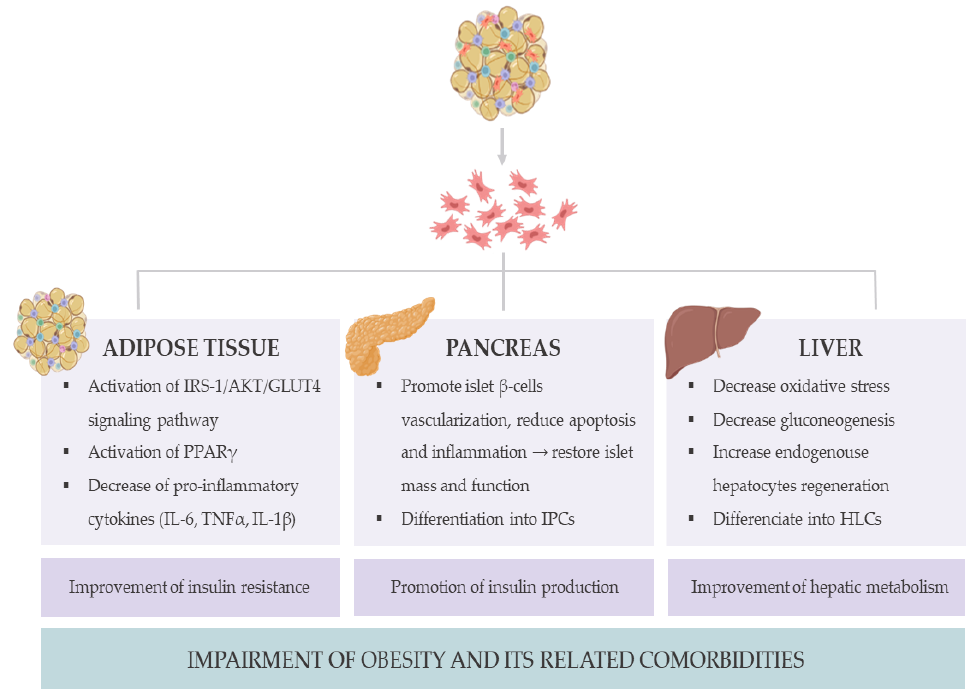
Figure 1. The mechanisms of action of ADMSC on obesity treatment. The transplantation of ADMSC reduces adipose tissue inflammation, restores glucose homeostasis by improving insulin sensitivity and promoting insulin production, and reverses liver steatosis. Abbreviation: ADMSCs, adipose- derived mesenchymal stem cells; AKT, serine/threonine kinase 1; GLUT4, glucose transporter 4; HLCs, hepatocyte-like cells; IL-1β, interleukin 1β; IL-6, interleukin 6; IPCs, insulin-producing cells; IRS-1, insulin receptor substrate 1; PPAR-γ, peroxisome proliferator-activated receptor gamma; and TNF-α, tumor necrosis factorα.